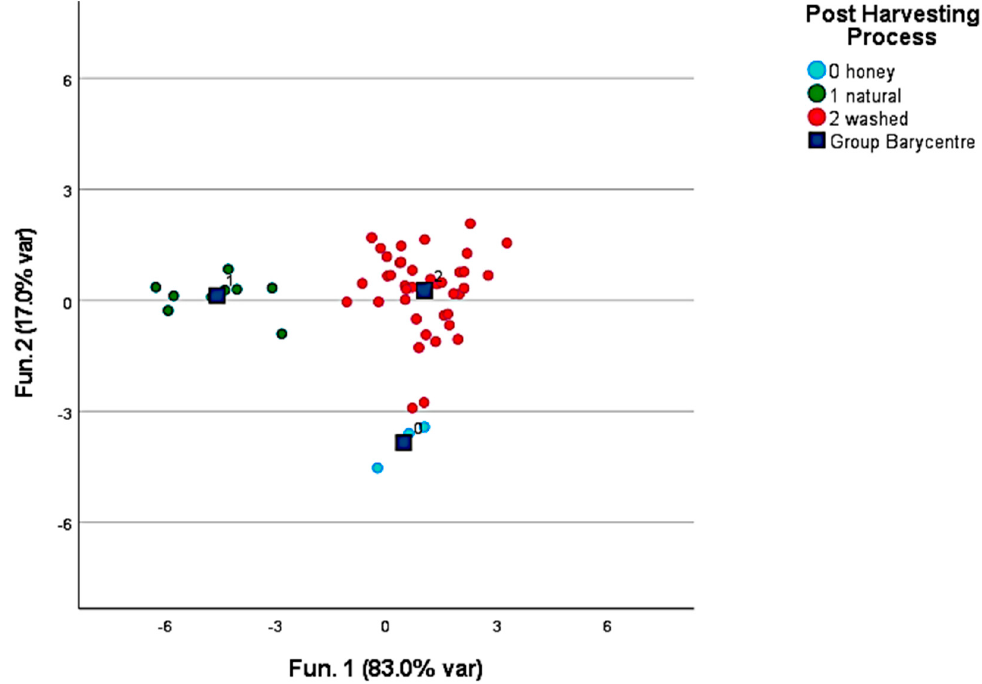
Figure 7. Discrimination of post ‐ harvesting processes in the African coffee subcluster.